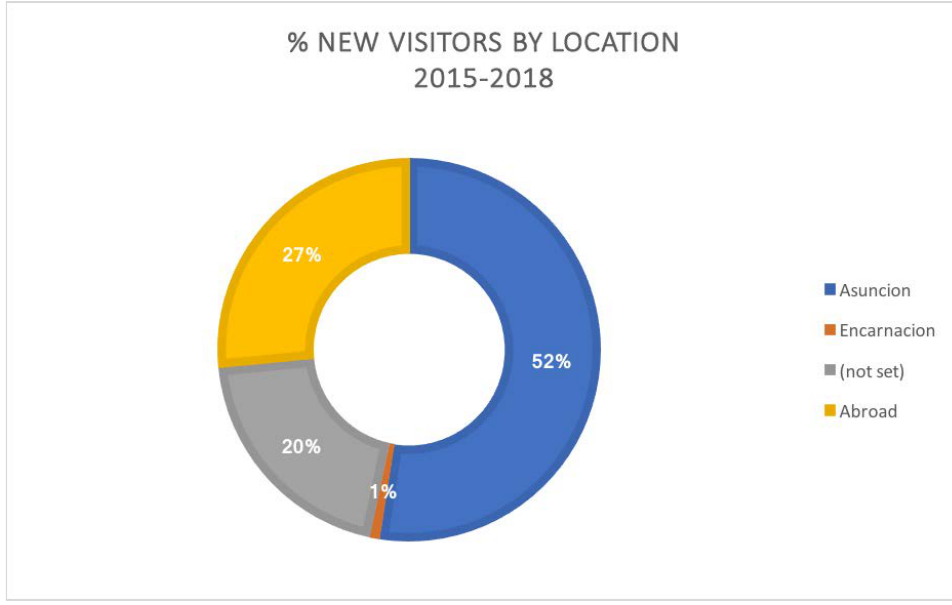
Source: Author’s